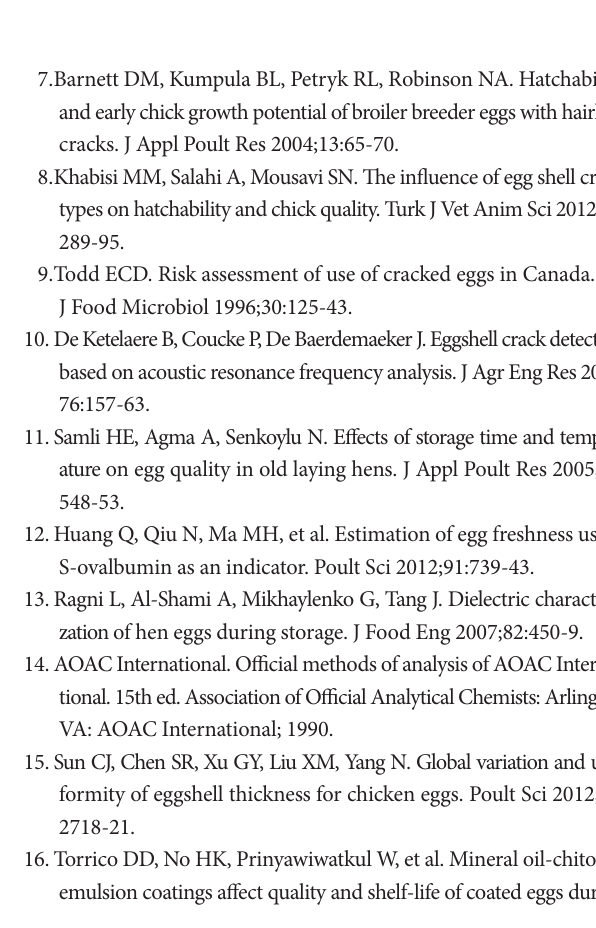
Figure 5. Appearance observation of (a) IE, (b) ME, (c) SE, and (d) CE eggs during storage. IE, intact egg; ME, minor stripe-marked egg; SE, severe stripe-marked egg; CE, cracked